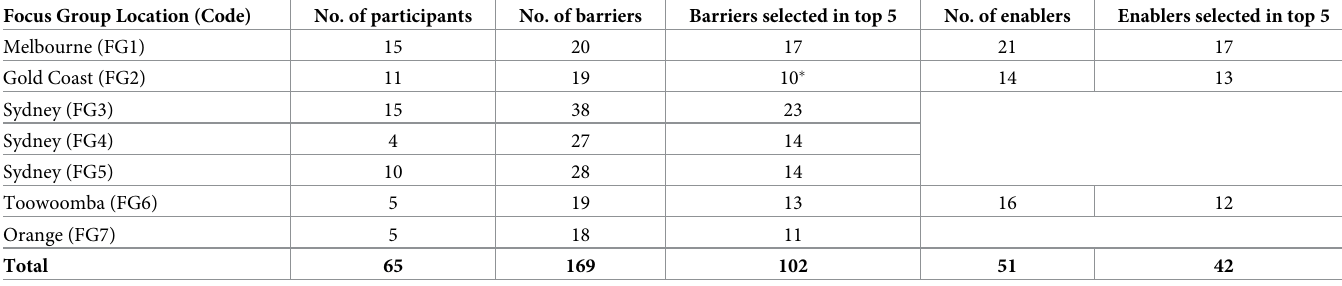
Table 2. Characteristics and output of optometry focus groups.